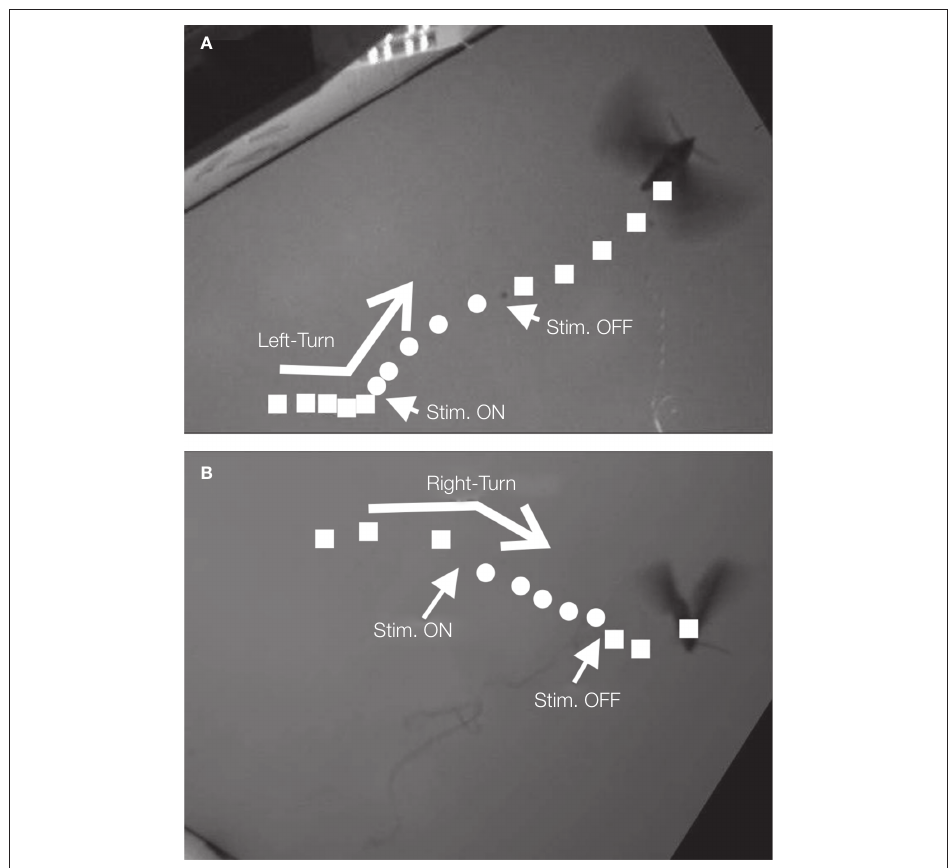
FIguRe 6 | Images showing the loosely tethered moth as in Figure 3. (A) left and (B) right turns. Reproduced from Tsang et al.